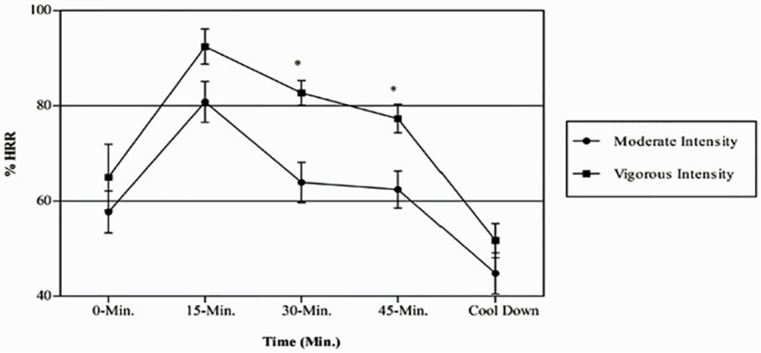
Physiological (%HRR) responses to the two exercise intensity trials.Data are shown as means ± standard error. * p < 0.01, moderate-exercise intensity significantly different from vigorous-exercise intensity.